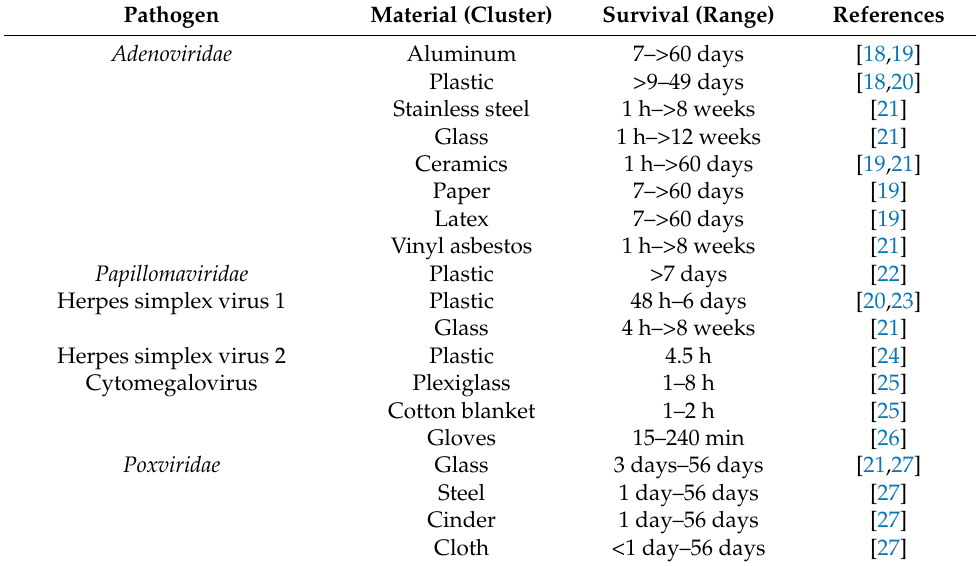
Table 1. Survival of DNA